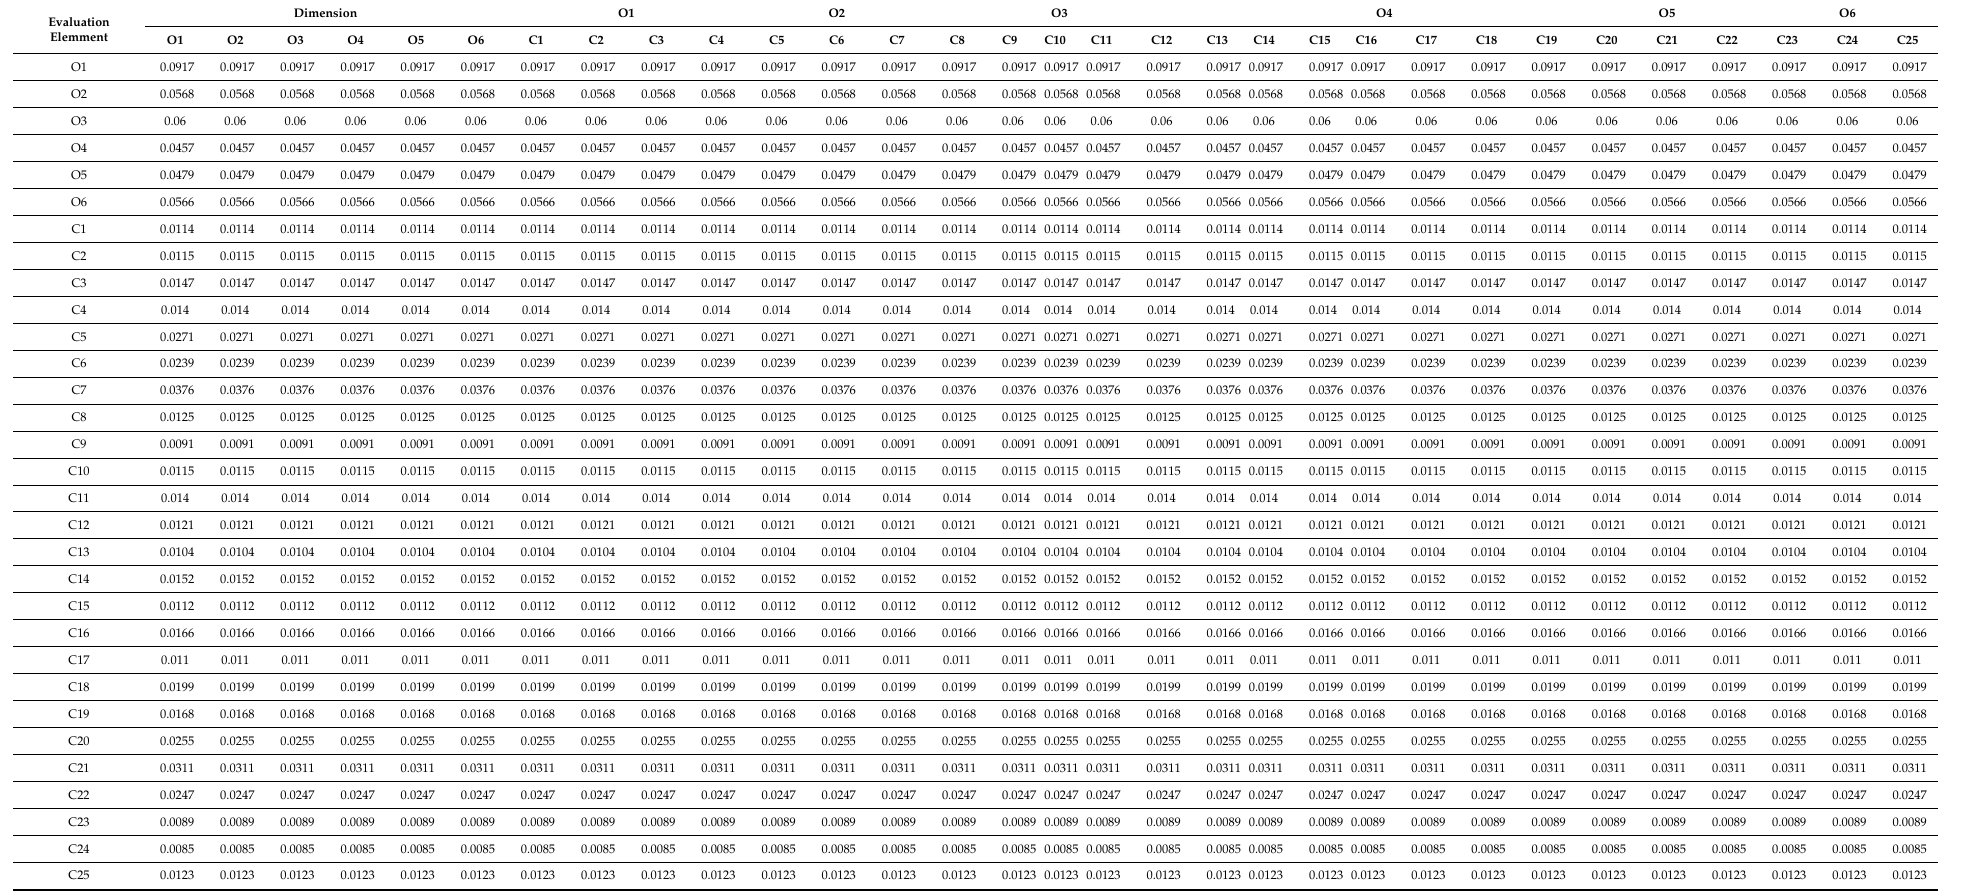
Table 10. The unnormalized limit